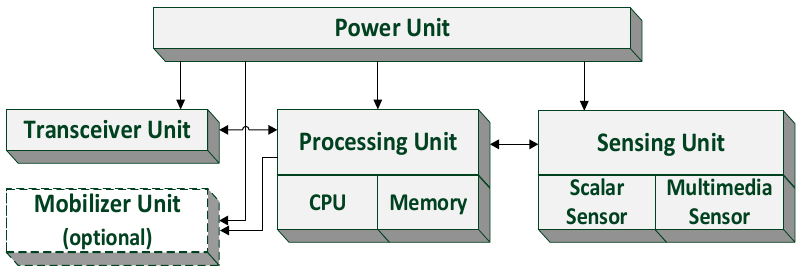
Figure 2. The components of a sensor node.